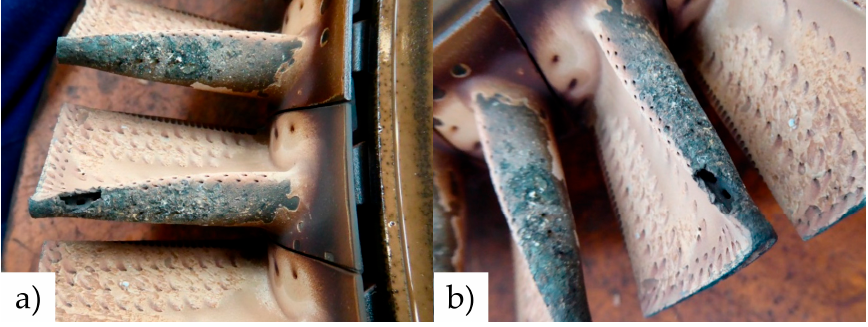
Figure 6. A burned blade at HPT [52].